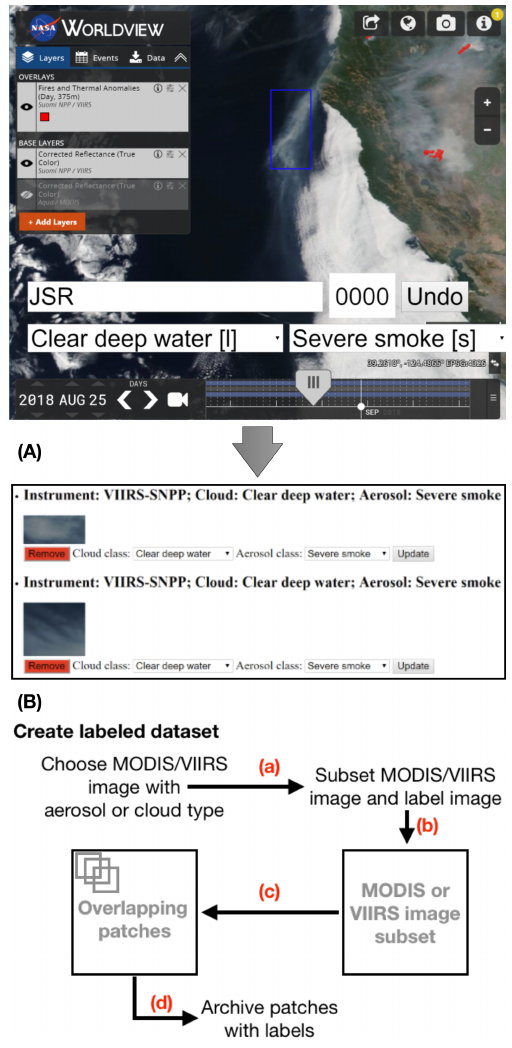
Figure 4. (A) The web interface through which a labeled dataset of aerosols and cloud types can be created. First the user decides what to label; e.g., in the above image the user chose to label cu- muliform clouds with a dust event. Then the user selects the region of interest (the blue rectangle over the aerosol event) via the mouse cursor; a counter increases (0002) to indicate the labeled image has been archived in a database. (B) To create the labeled dataset (a) a MODIS or VIIRS image is chosen through the web interface, (b) the selected region of interest is used to create a subset of the MODIS or VIIRS image, (c) the subset image is divided into overlapping patches and (d) the patches are archived with the corresponding la-